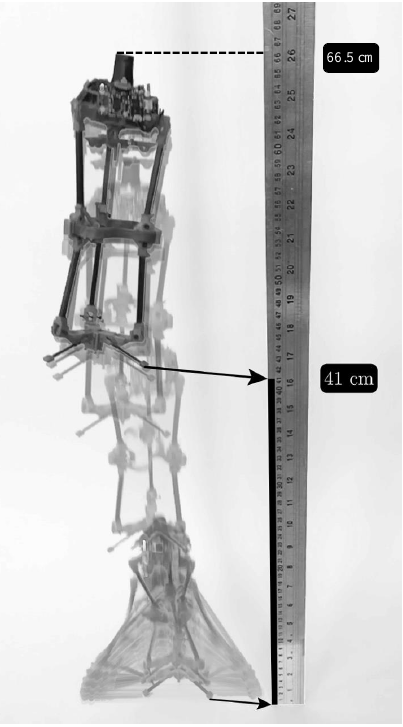
Figure 1. The three-legged jumping robot and its vertical jumping recording [17].